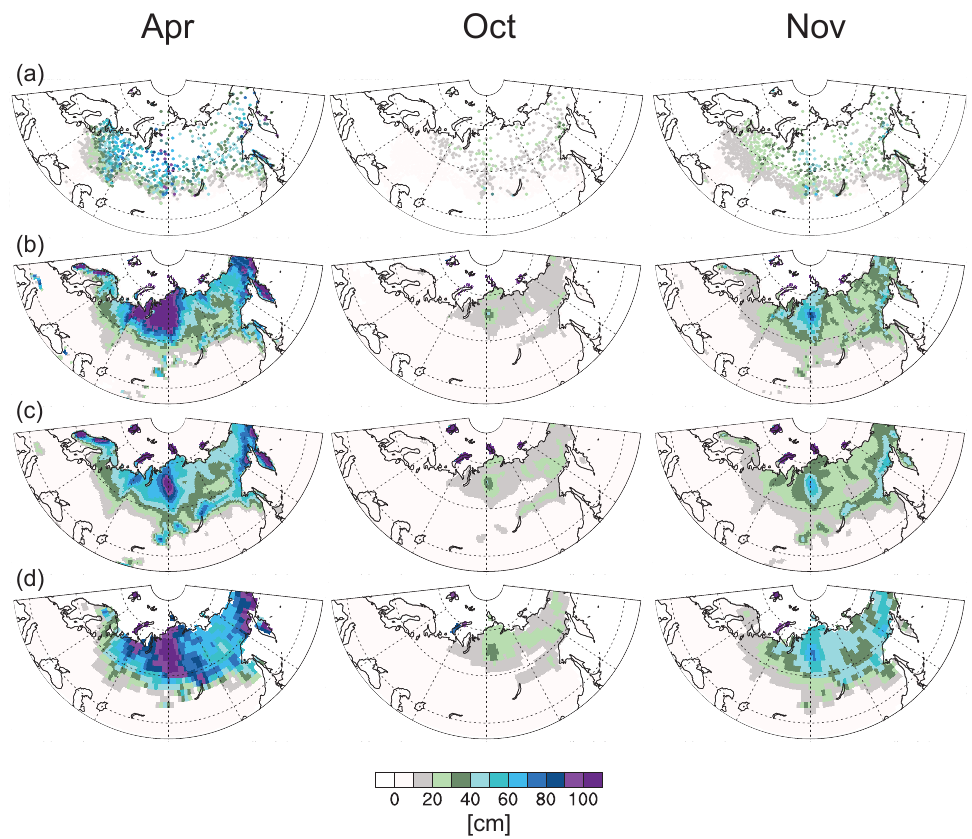
Figure 1. Mean maximum snow depth climatology of (from left to right) April, October and November during the 1981–2010 period in (a) observations, (b) ERA-Interim land-d, (c) ERA-20C and (d) 20CRv2c. ERA-20C land, ERA-Interim land-e and 20CRv2 are not